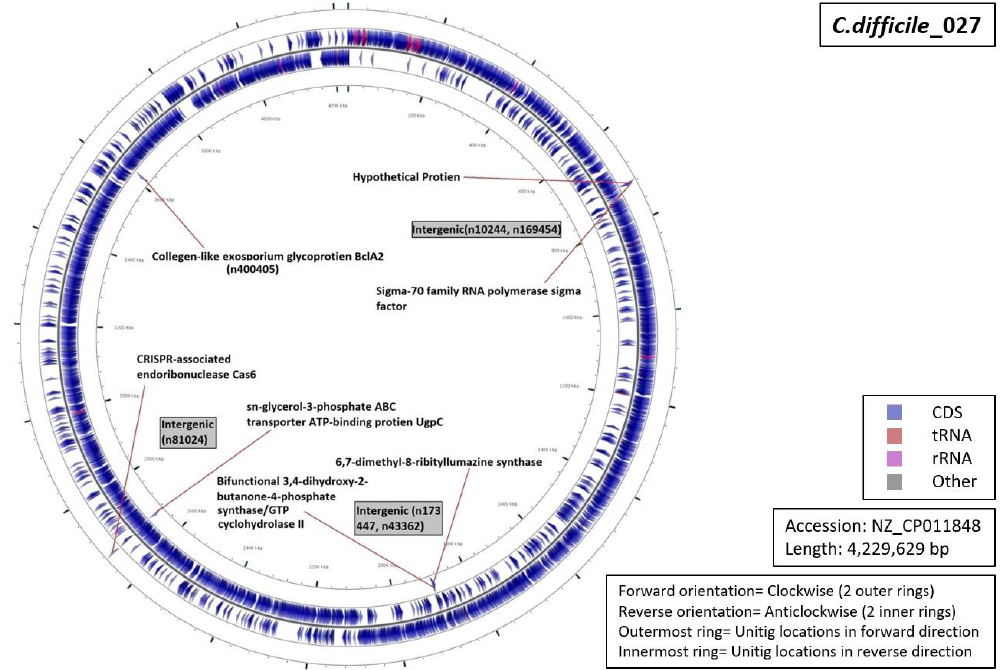
Figure 6. Functional annotation and location of DBGWAS markers on the reference genome of C. difficile RT017.